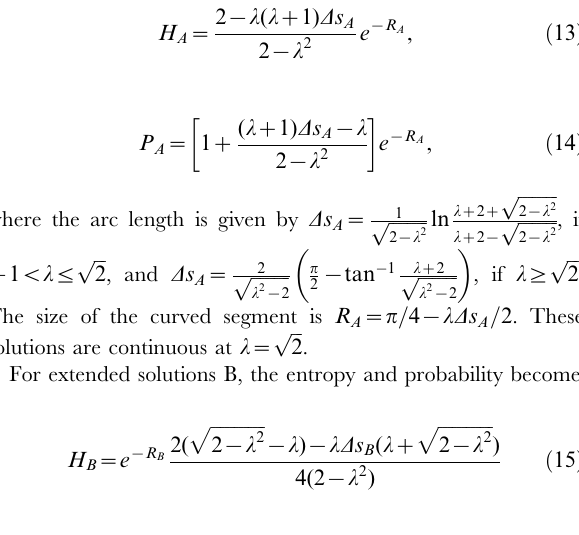
cf. Figure 3. Extended solutions B are symmetric around y = x line, and exist only for 2 1 , l , 0, while extended solutions C are symmetric around x =0 line, and exist for 2 1 , l ,